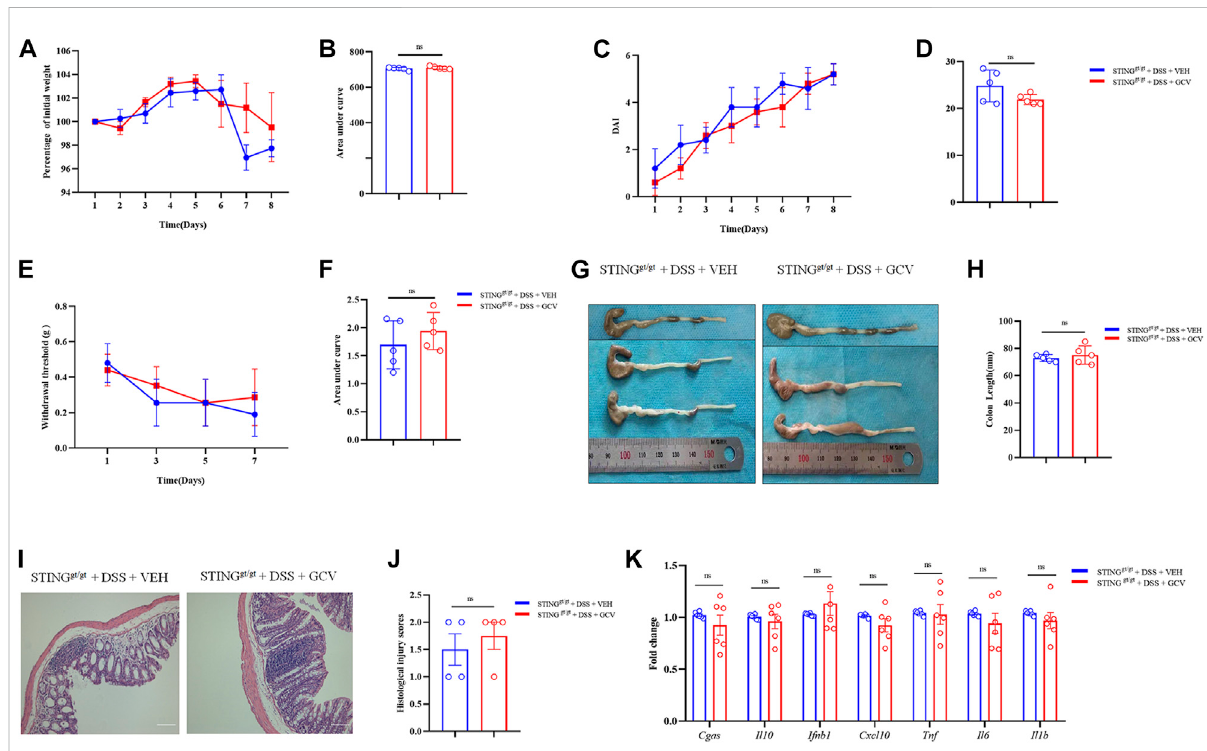
FIGURE 9 Low-dose GCV had no therapeutic effects on DSS-colitis in mice. (A) DSS-colitis induced body weight changes in different groups. (B) The quanti fi cation of AUC for (A) . (C) DSS-colitis induced DAI score changes of mice in different groups. (D) The quanti fi cation of AUC for (C) . (E) DSS- colitis induced mechanical pain hypersensitivity in the abdomen in mice from different groups. (F) The quanti fi cation of AUC for (E) . ( n = 5-7 per group; n.s., no signi fi cance, # p < 0.05, ### p < 0.001, GCV + DSS vs. DSS group; & p < 0.05, &&& p < 0.001, STING gt/gt + DSS vs DSS group; two-way ANOVA with post-hoc Bonferroni test). (G) Representative pictures of colons from different groups. (H) Quanti fi cation of the colonic length for (G) . ( n = 5-7 each group; ## p < 0.01; ### p < 0.001; unpaired Student ’ s t -test). (I) Representative photographies of H&E staining of colon sections from differentgroups. (J) Statisticalresultsfor (I) ( n =4eachgroup; # p < 0.05;unpairedStudent ’ s t -test). (K) Q-PCRanalysisshowedthemRNAexpression changes of Cgas , Il10 , Cxcl10 , Ifnb1 , Tnf , Il6 , and Il1b from different group ( n = 6 per group, unpaired Student ’ s t -test). All data was expressed as Mean ± SEM. n.s., no signi fi